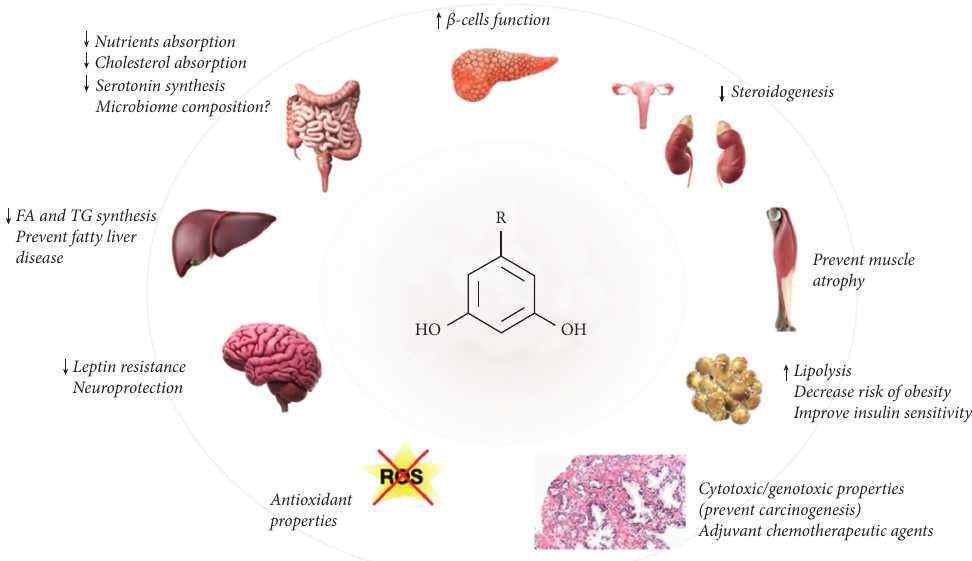
Figure 5: The main regulatory functions of ARs according to in vivo and in vitro